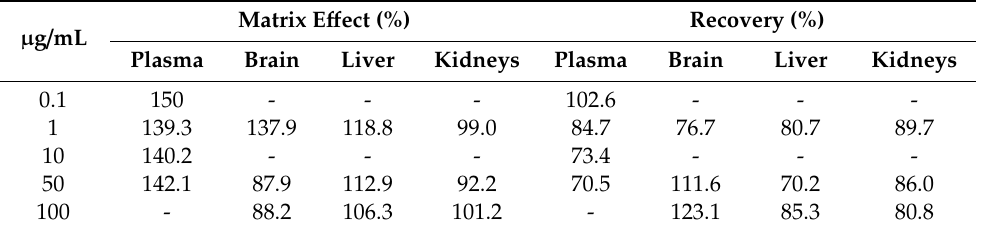
Table 5. Matrix e ff ect and recovery of Si306 in mice plasma, brain, liver and kidneys ( n = 3). µ g /